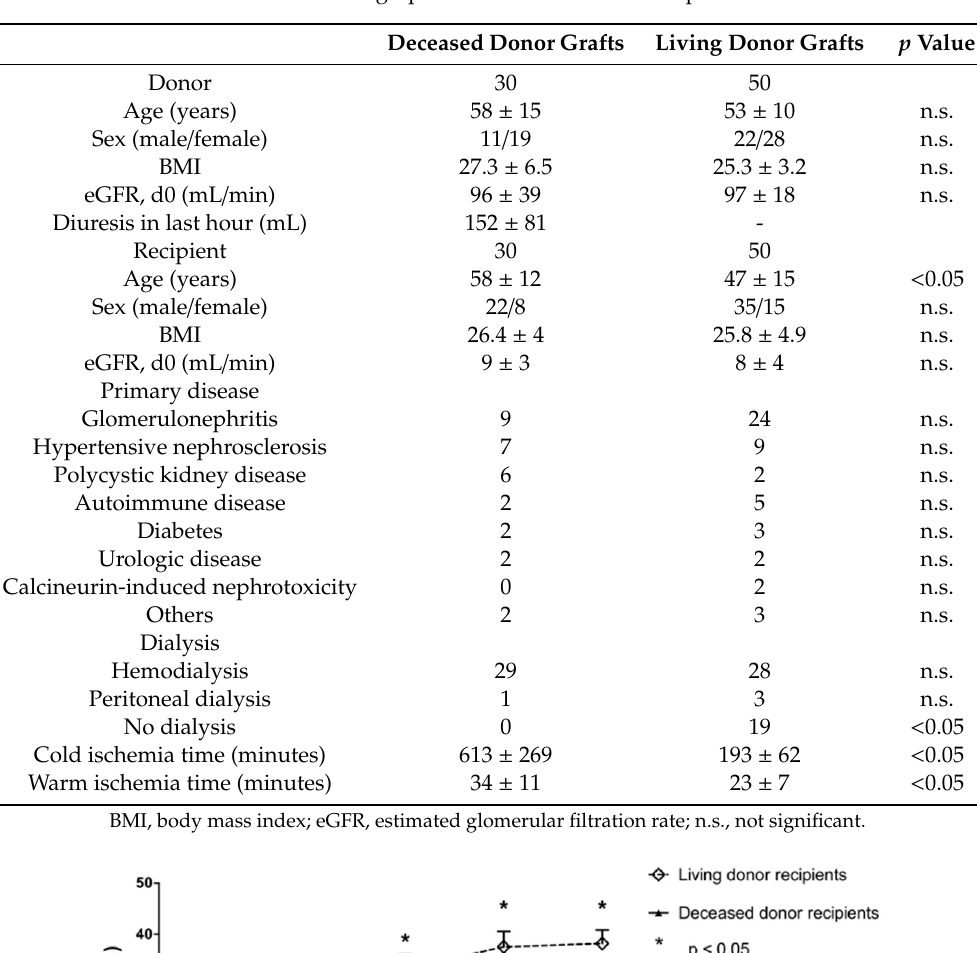
Table 1. Demographic data of donors and recipients.